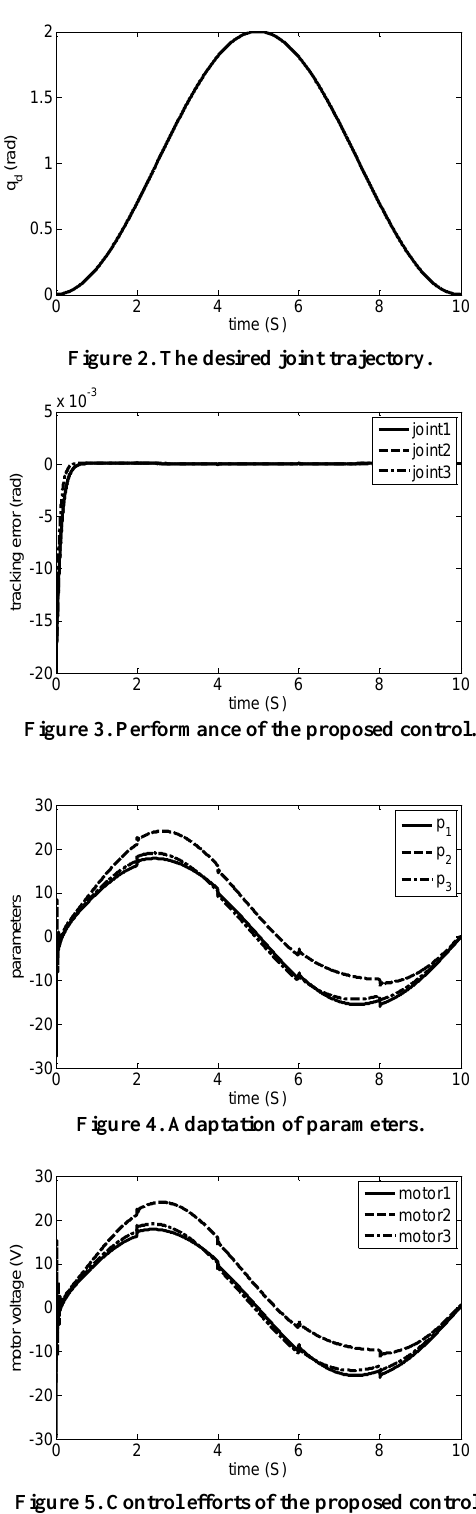
Figure 7. Control efforts of the robust NN